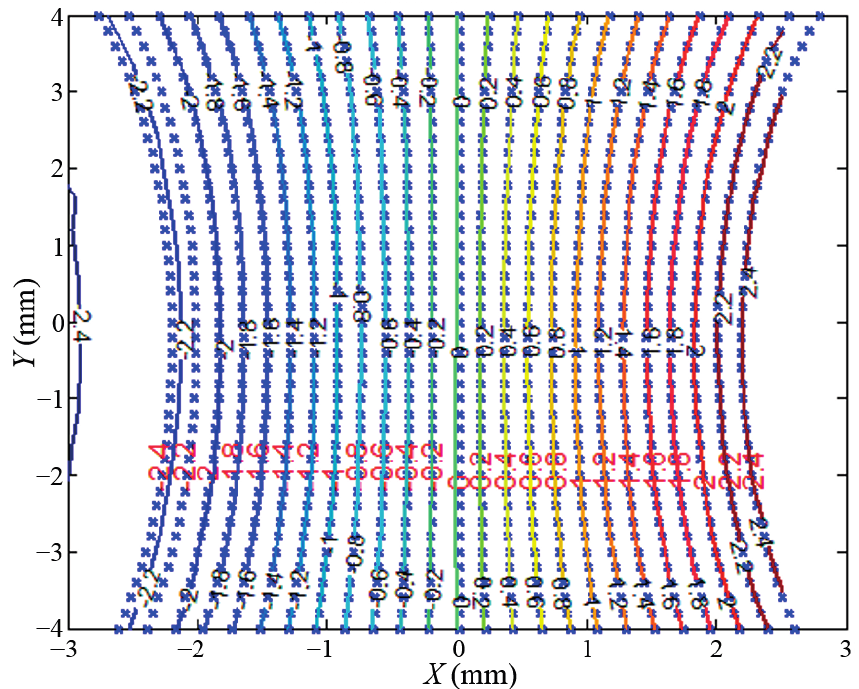
Figure 12. Fitting performance of the parameters f n 1 ( U ), f n 2 ( U ) and f n 3 ( U